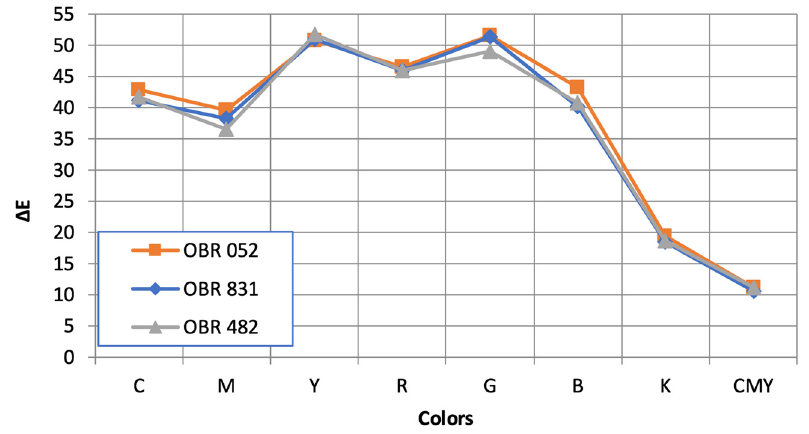
Figure 12. Different colors changes of Δ E on melange linen fabrics when printing in 4 passes with